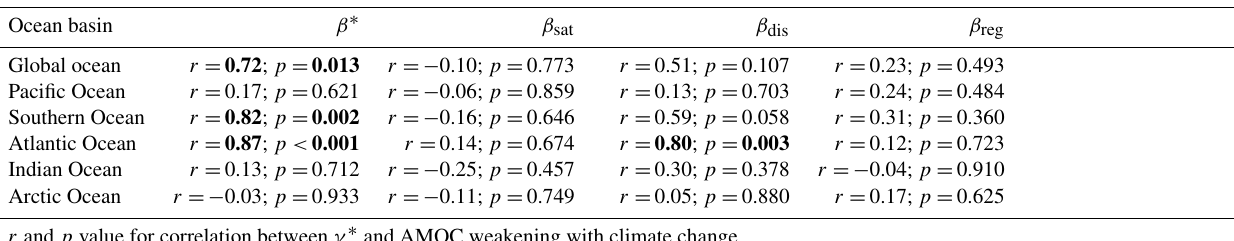
Table 4. Correlation between the ocean carbon–concentration feedback parameter based on carbon storage, β ∗ , and the pre-industrial strength of the Atlantic Meridional Overturning Circulation (AMOC) and correlation between the ocean carbon–climate feedback parameter based on carbon storage, γ ∗ , and the AMOC weakening due to climate change, along with the contribution from the saturated, disequilibrium and regenerated carbon pools based on 11 CMIP6 models (Table 1). For the regenerated part of γ ∗ , correlations estimated excluding the CNRM-ESM2-1 model, which has substantially larger changes in the regenerated carbon with warming than the rest of the Earth system models, are presented as (cid:98) γ reg . The correlation is expressed as a correlation coefficient, r , and a p value. The level of significance is assumed to be 0.05, and the statistically significant correlations with p < 0 . 05 are highlighted by bold text. Diagnostics are from years 121 to 140 (the 20 years up to quadrupling of atmospheric CO 2 ). Note that for the global ocean, β ∗ and γ ∗ are equivalent to β and γ . r and p value for correlation between β ∗ and pre-industrial AMOC